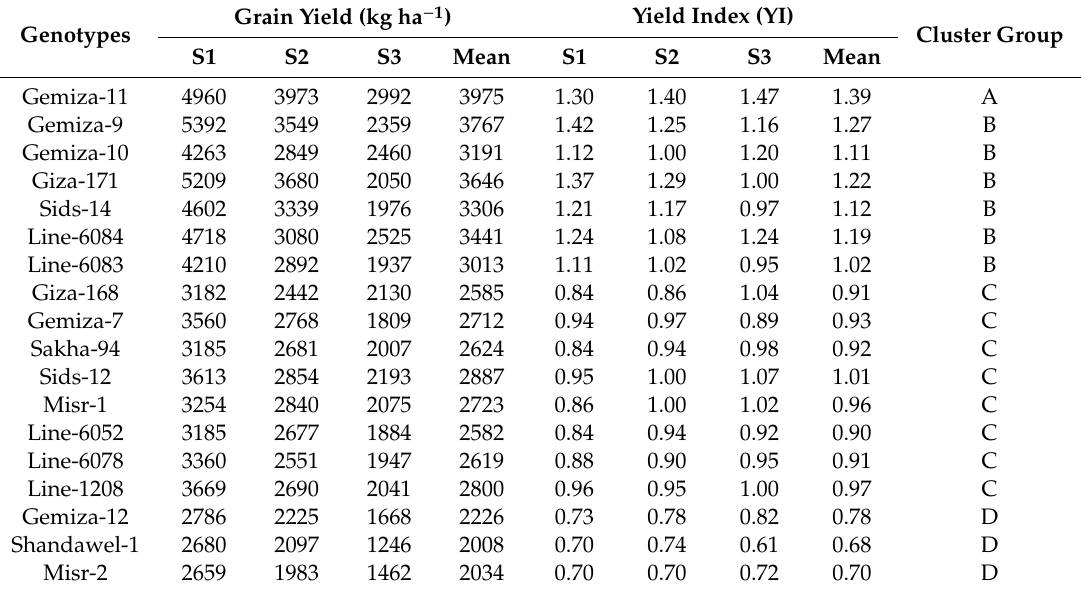
Table 1. Grain yield and YI of 18 wheat genotypes under the three salinity levels of S1 (5.25 dS m − 1